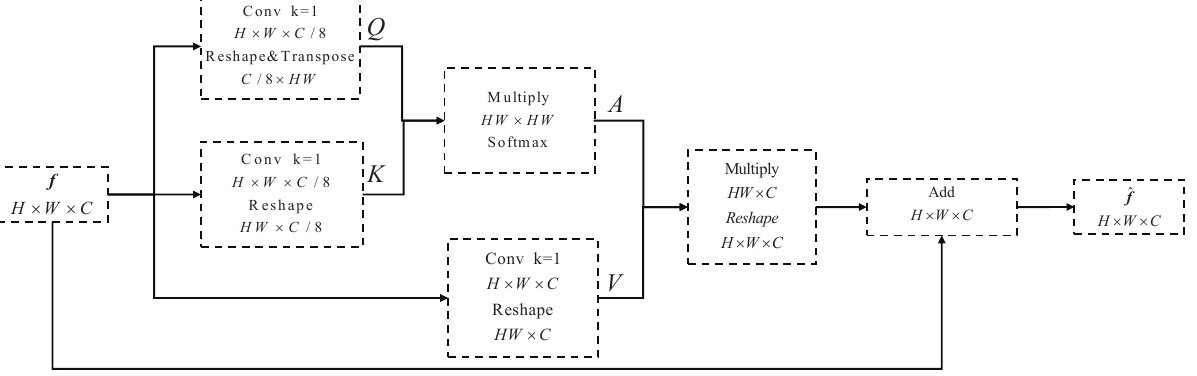
Figure 3. Pixel Attention Module. H , W , C denote height, width, and channel sizes of feature maps, respectively, and k denotes the kernel